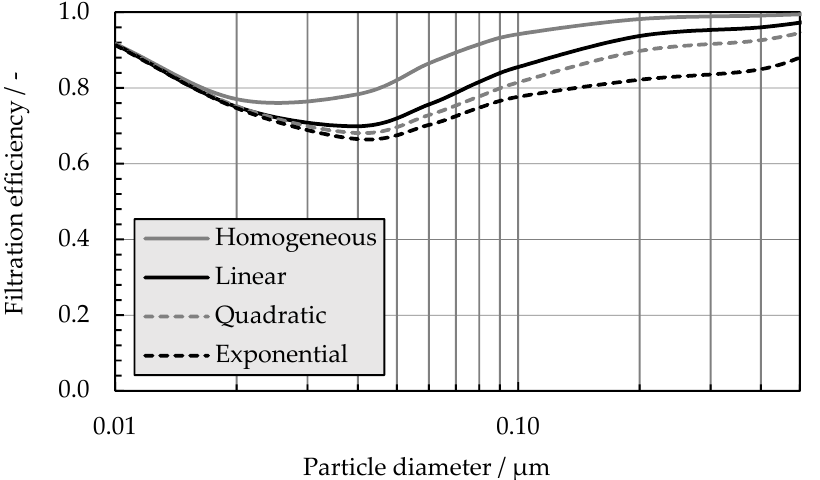
Figure 8. Filtration efficiency using sodium chloride particles in bipolar equilibrium charge distribution and a face velocity of 0.02 m · s − 1 depending on the decrease of electric charge magnitude.